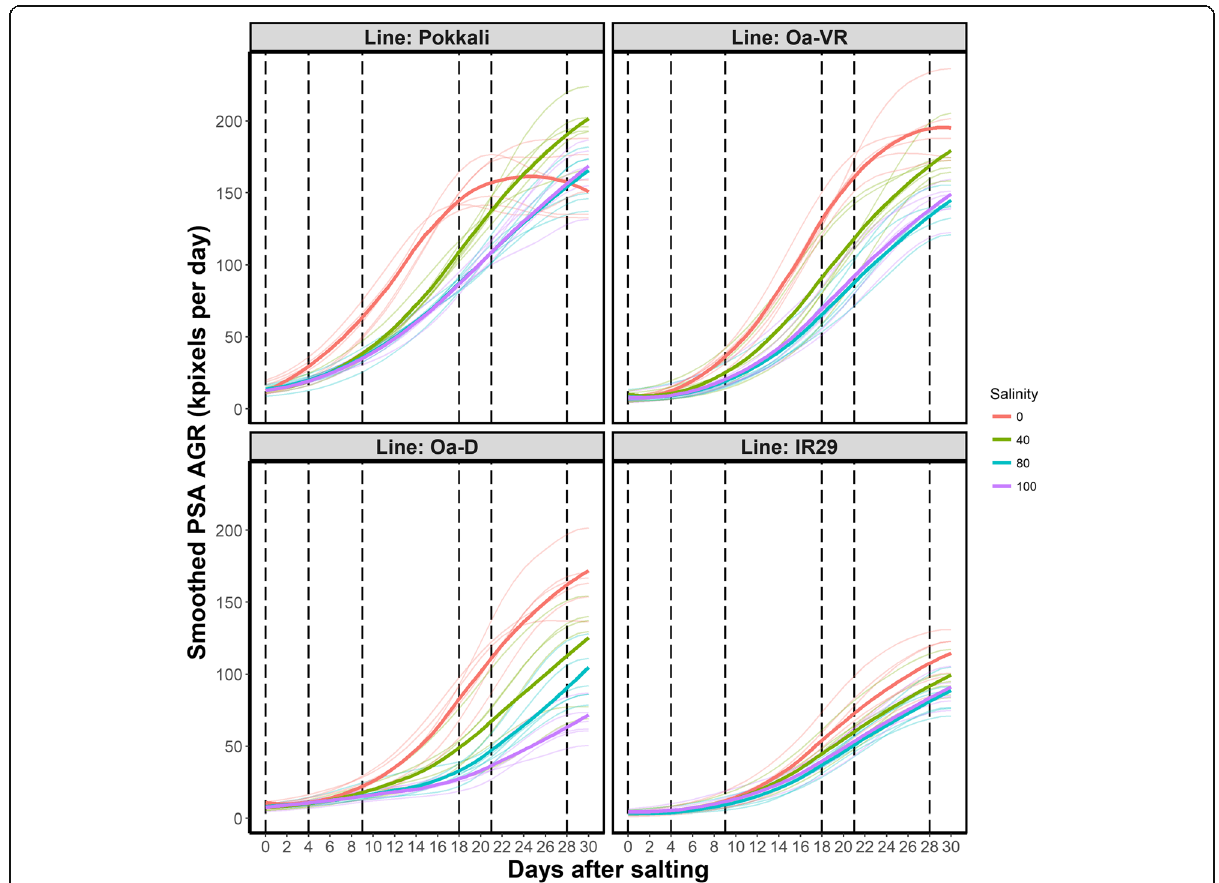
Fig. 3 Absolute growth rates of Pokkali, Oa -VR, Oa -D and IR29 from 0 to 30 DAS including non-salinised controls. Smoothed AGR values were derived from projected shoot area (PSA) values to which splines had been fitted. Thin lines represent individual plants. Bold lines represent the grand average of the six replicates plants for each treatment. The vertical broken lines represent the tested